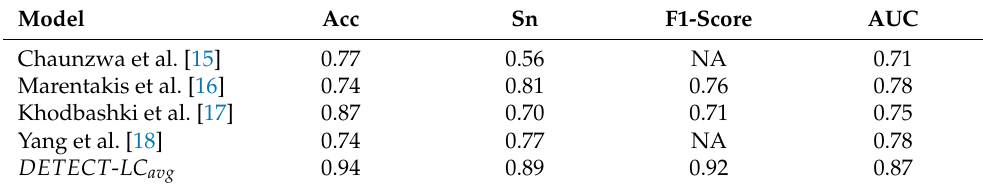
Table 7. State of the Art Tumor Phenotyping Results on TCIA NSCLC Datasets.